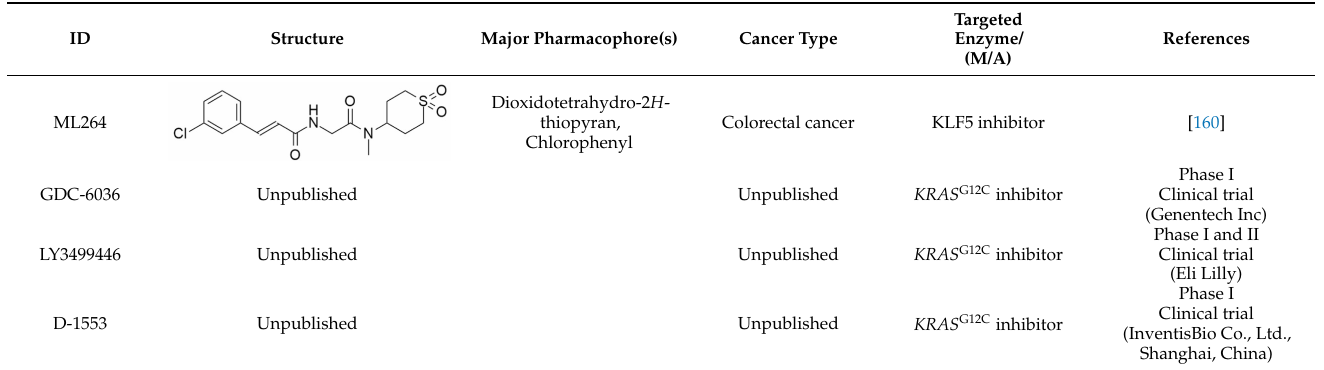
Table 6. Miscellaneous small-molecule RAS